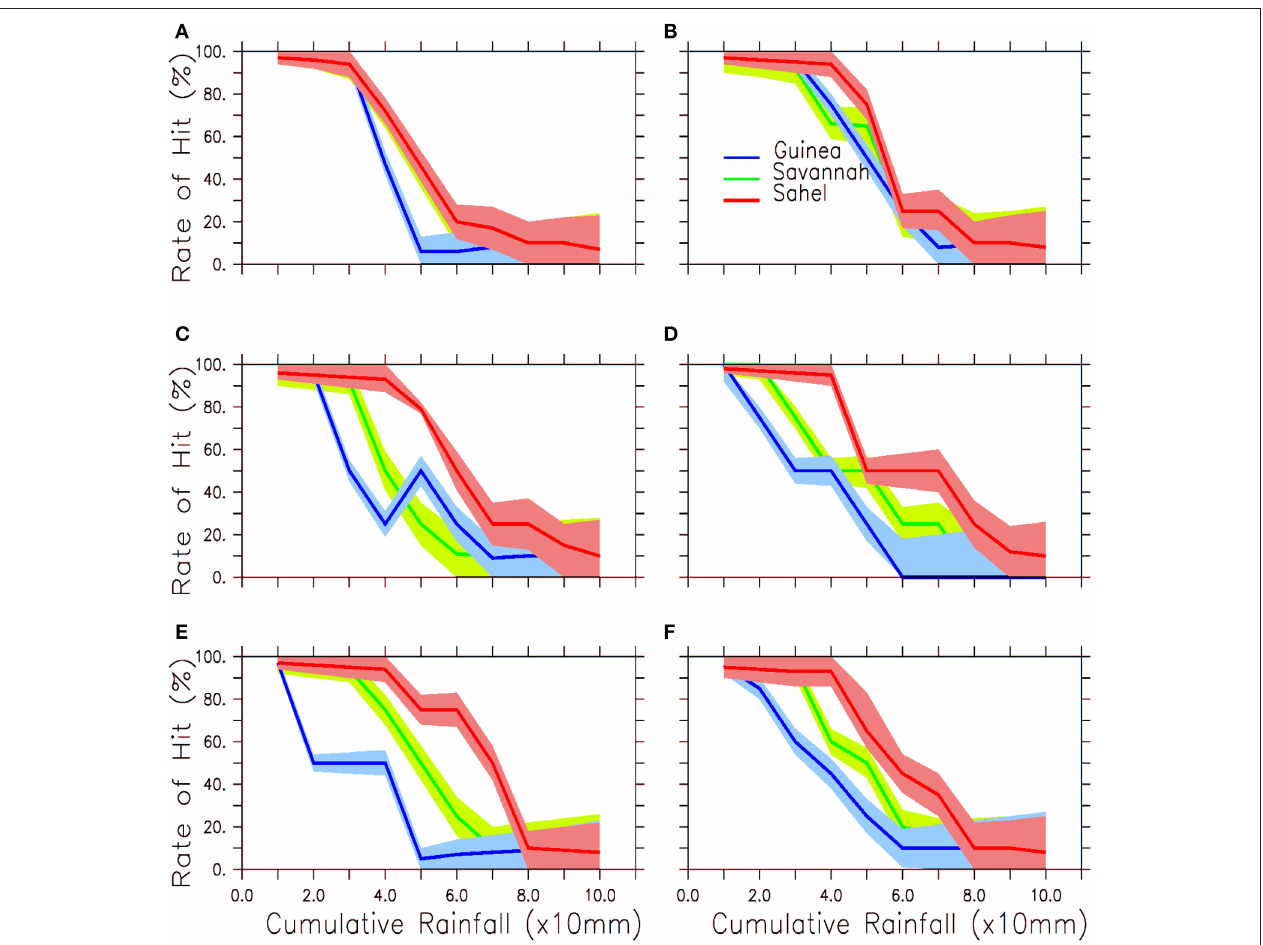
FIGURE 9 | Percentage of hit of weekly cumulative rainfall amount (mm) by the ECMWF-S2S model over Nigeria; Sahel (red line and shade), Savannah (green line and shade) and Guinea (blue line and shade) in August (A) 2004, (B) 2009, (C) 2010, (D) 2011, (E) 2012, and (F) climatology.